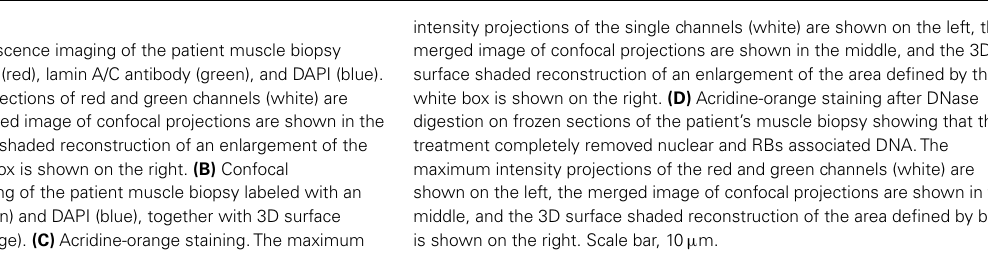
intensity projections of the single channels (white) are shown on the left, the merged image of confocal projections are shown in the middle, and the 3D surface shaded reconstruction of an enlargement of the area defined by the white box is shown on the right. (D) Acridine-orange staining after DNase digestion on frozen sections of the patient’s muscle biopsy showing that the treatment completely removed nuclear and RBs associated DNA.The maximum intensity projections of the red and green channels (white) are shown on the left, the merged image of confocal projections are shown in the middle, and the 3D surface shaded reconstruction of the area defined by box is shown on the right. Scale bar, 10 µ m.